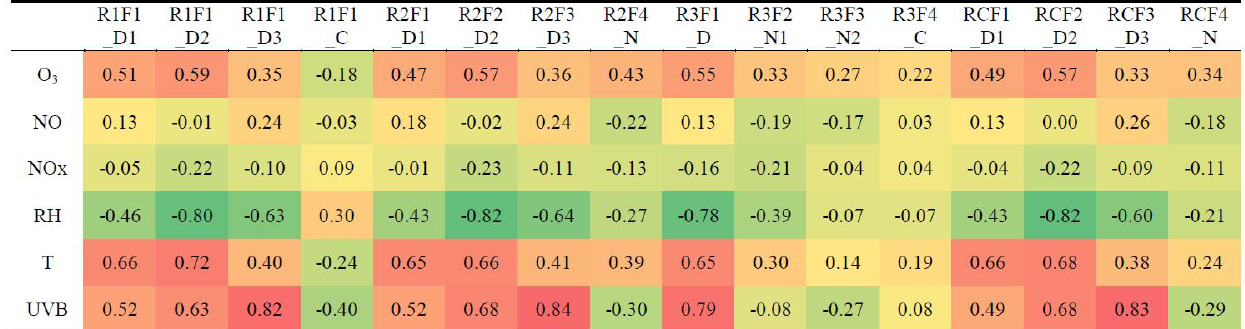
Table 2. Correlation between factors and meteorological parameters and